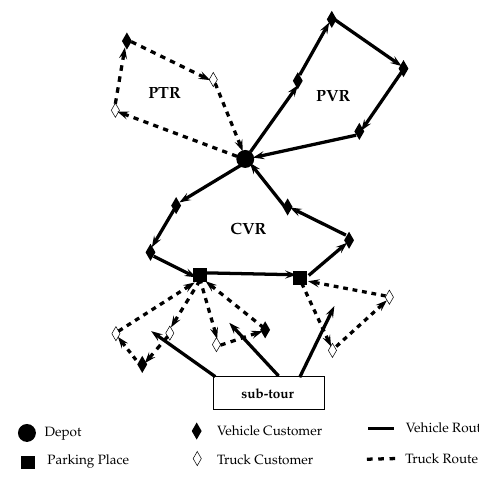
Fig. 1. Routes types in the